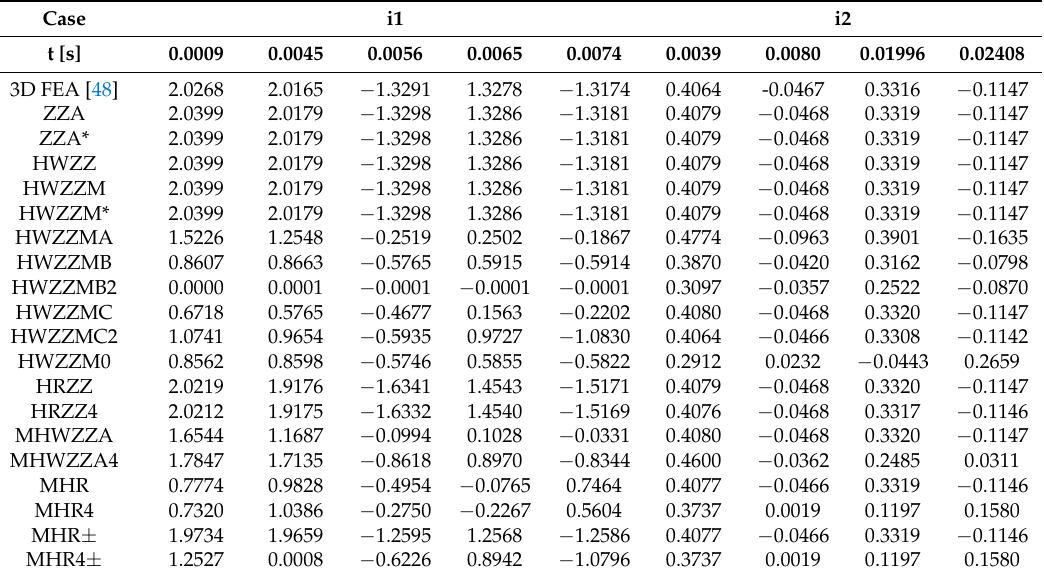
Table 20. Normalized fundamental frequencies, cases i1 and